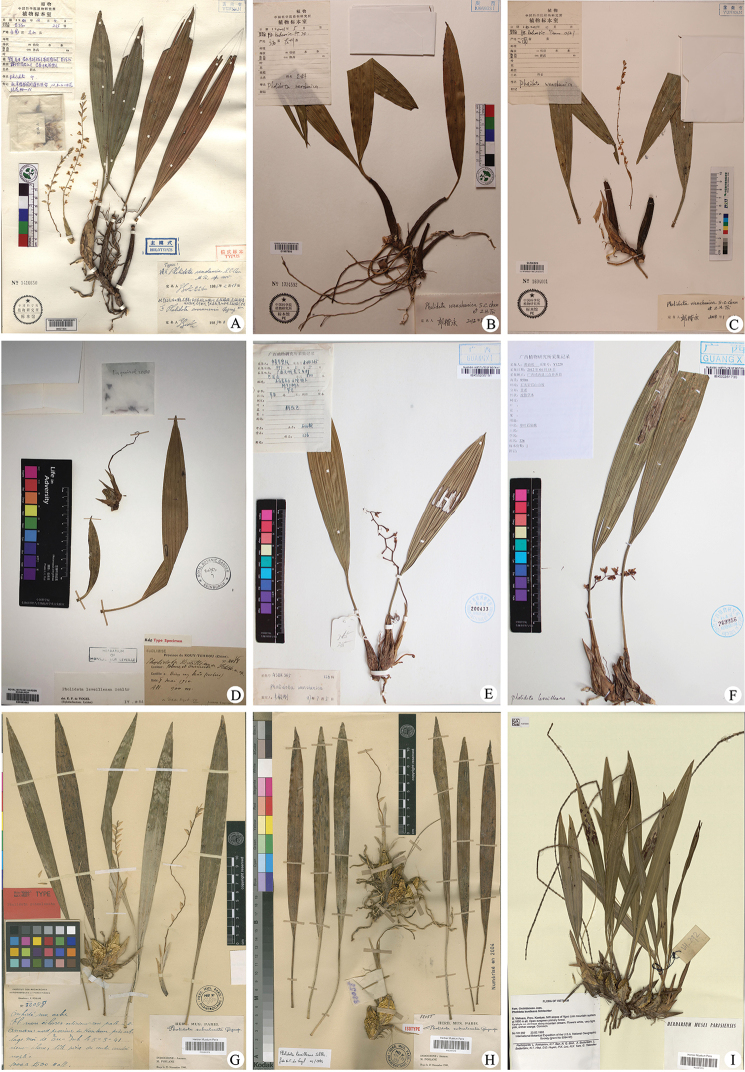
The types and selected specimens of P.
wenshanica (A–C), Pholidota
leveilleana (D–F) and P.
subcalceata (G–I) A holotype sheet of P.
wenshanicaB China, Guangxi, Longzhou, HK Kadoorie PT 714 (PE) C China, Yunnan, HK Kadoorie Team 2361 (PE) D holotype sheet of P.
leveilleanaE China, Guangxi, China-UK Expedition Team ASBK365 (IBK) F China, Guangxi, Y.S. Huang Y1229 (IBK) G Holotype sheet of P.
subcalceataH isotype sheet of P.
subcalceataI Vietnam, Kontum, L.V. Averyanov & al., VH 292 (P).